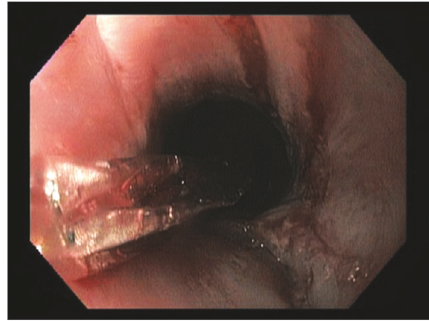
Figure 3: Proximal stricture treated with dilatation.